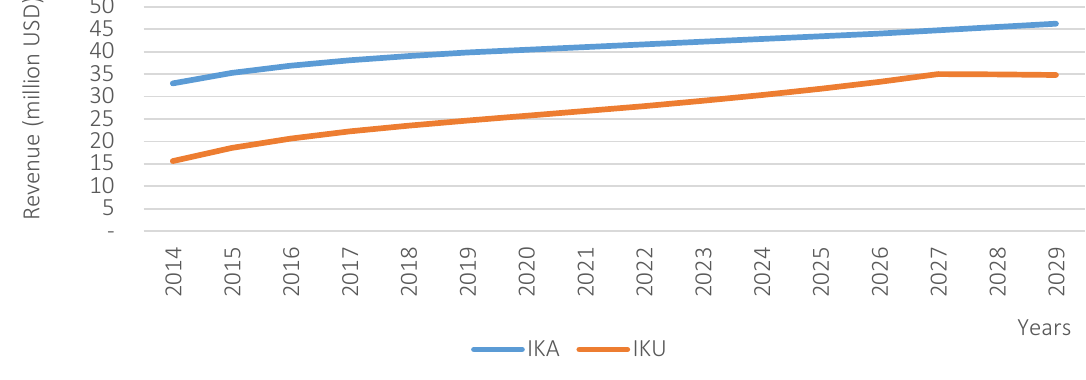
Figure 2. Simulation graph of scenario